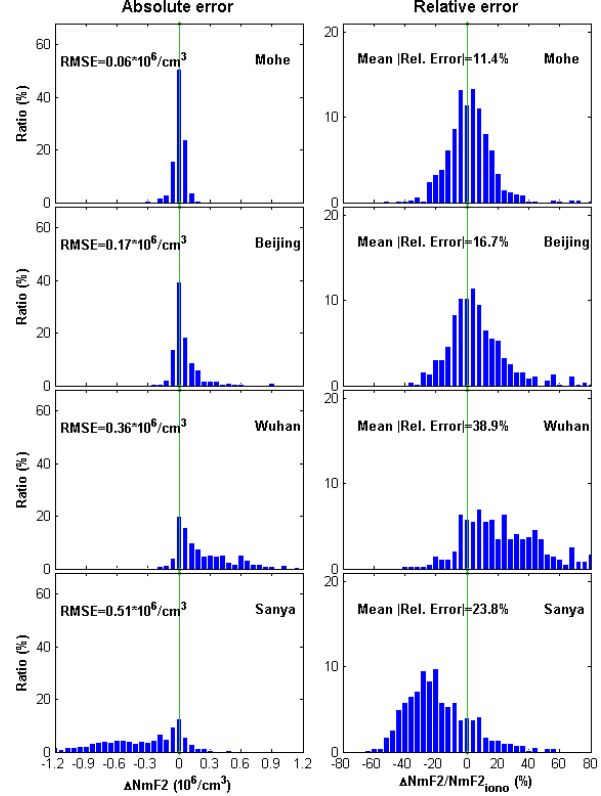
Figure 4. Absolute and relative errors of Nm F2s from COSMIC and ionosonde